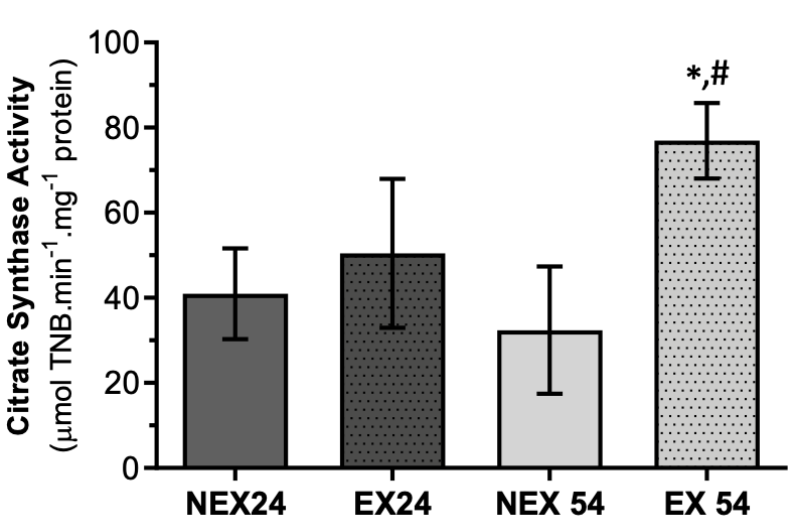
Figure 2. Effect of ageing and training in Citrate synthase activity. Values are means ± SD ( n = 7), with two replicates. * p < 0.05 compared with NEX24; # p < 0.05 compared with NEX54; NEX24 (non-exercising young, sacrifice at 24 weeks of training), EX24 (exercise young, sacrifice at 24 weeks of training), NEX54 (non-exercising middle-age, sacrifice at 54 weeks of training), EX54 (exercise middle-age, sacrifice at 54 weeks of training).